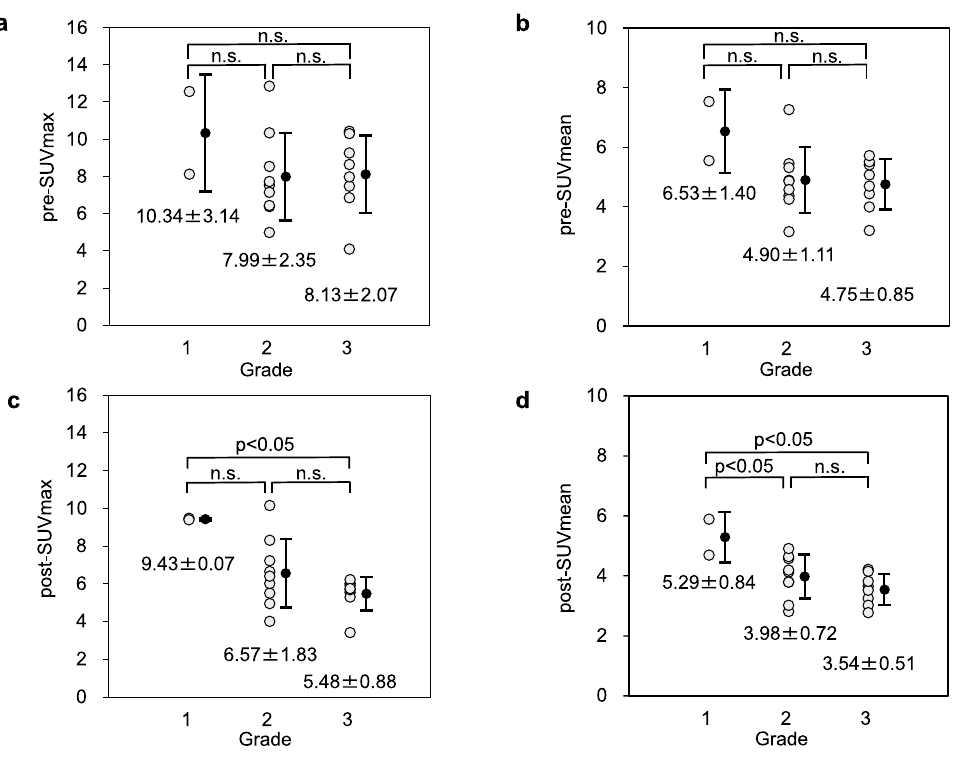
Figure 1. PET imaging parameters of MET uptake and all grades. There was no significant difference in the pre-SUVmax among all grades ( a ). There was also no significant difference in the pre-SUVmean among all grades ( b ). There was a significant difference in post-SUVmax between Grades 1 and 3 ( p < 0.05 ) ( c ). There was also a significant difference in post-SUVmax between Grades 1 and 2 ( p < 0.05 ) and Grades 1 and 3 ( p < 0.05 ) ( d ). The Tukey ‒ Kramer honestly significant difference test was used for statistical